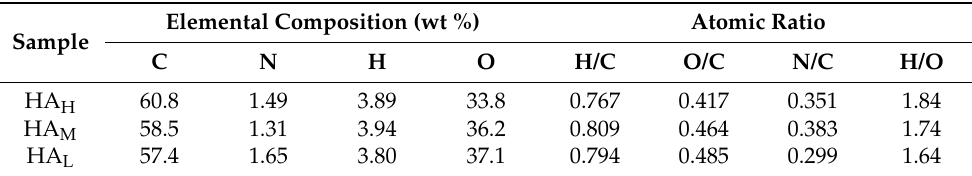
Table 1. Elemental composition (moisture and ash free) and atomic ratio of the HA fractions derived from Chinese weathered